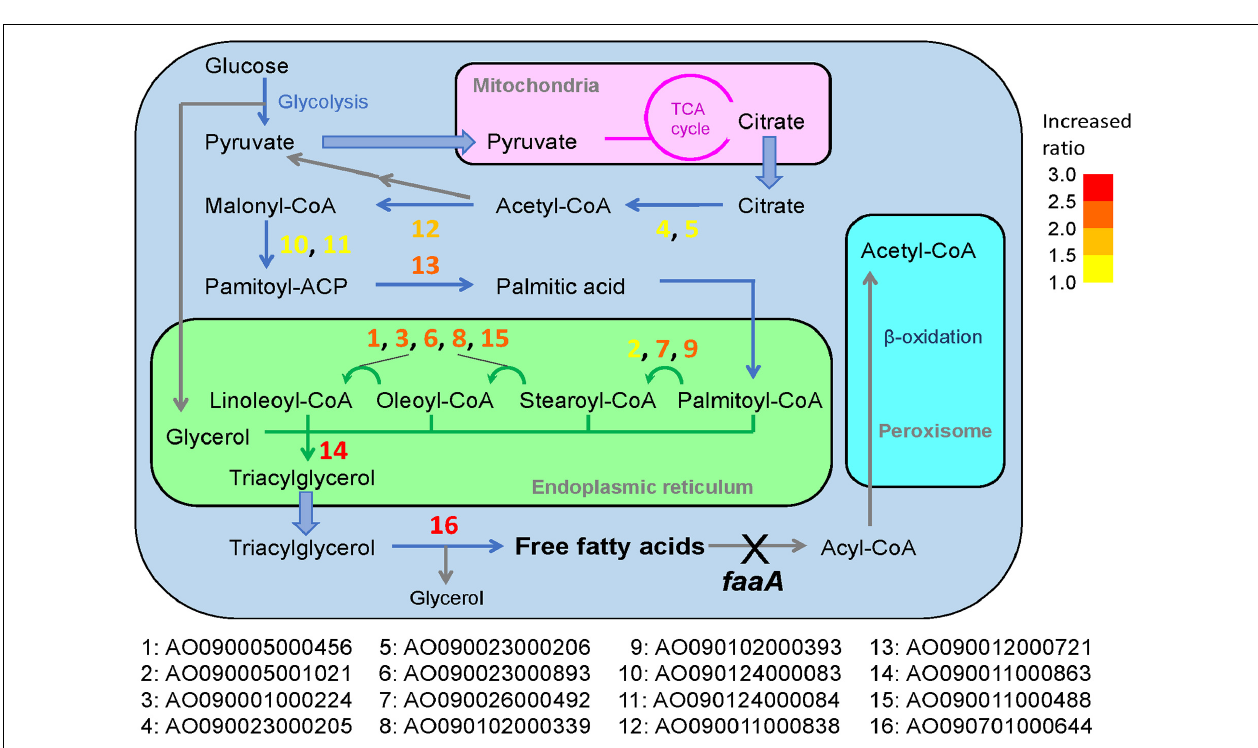
FIGURE 3 | FFA secretory productivity and yield of the 16 overexpression mutants relative to those of the (cid:49) faaA strain. Each gene overexpression mutant derived from the (cid:49) faaA strain was tested for both FFA secretory productivity (A) and FFA secretory production yield (B) in conjunction with the (cid:49) faaA strain. The overexpression mutants containing two overexpressed genes were named with the two gene IDs along with “&.” This also indicated that they are subunits of the same enzyme complex and were modified together. The productivities of the 16 overexpressed mutants and the parental (cid:49) faaA strain were tested using Student’s t -test and those with p -value < 0.01 are marked with “**”. The actual yield of each mutant is shown above each bar in italics.